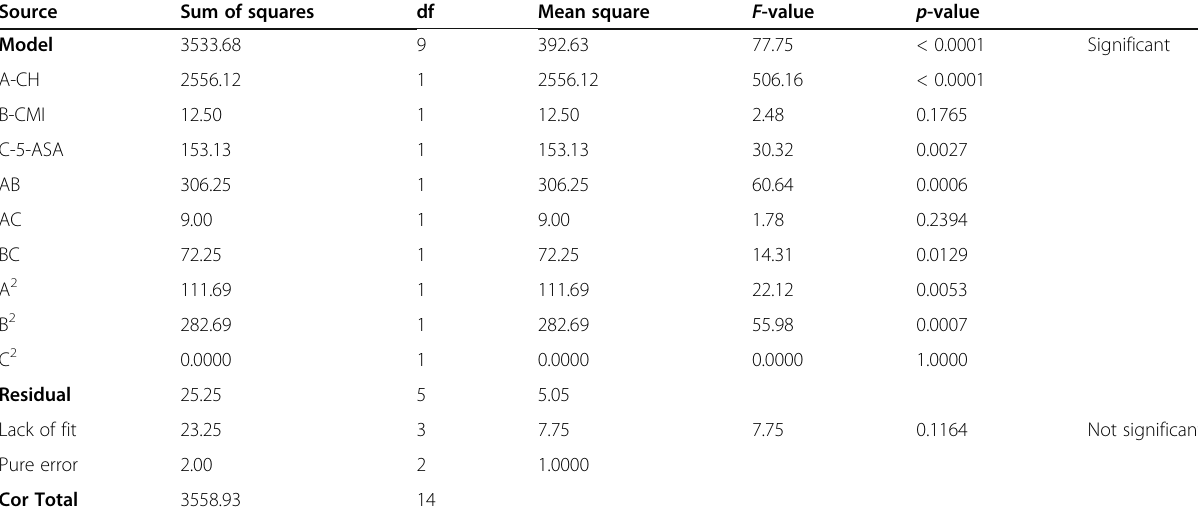
Table 3 Particle size statistical analysis result